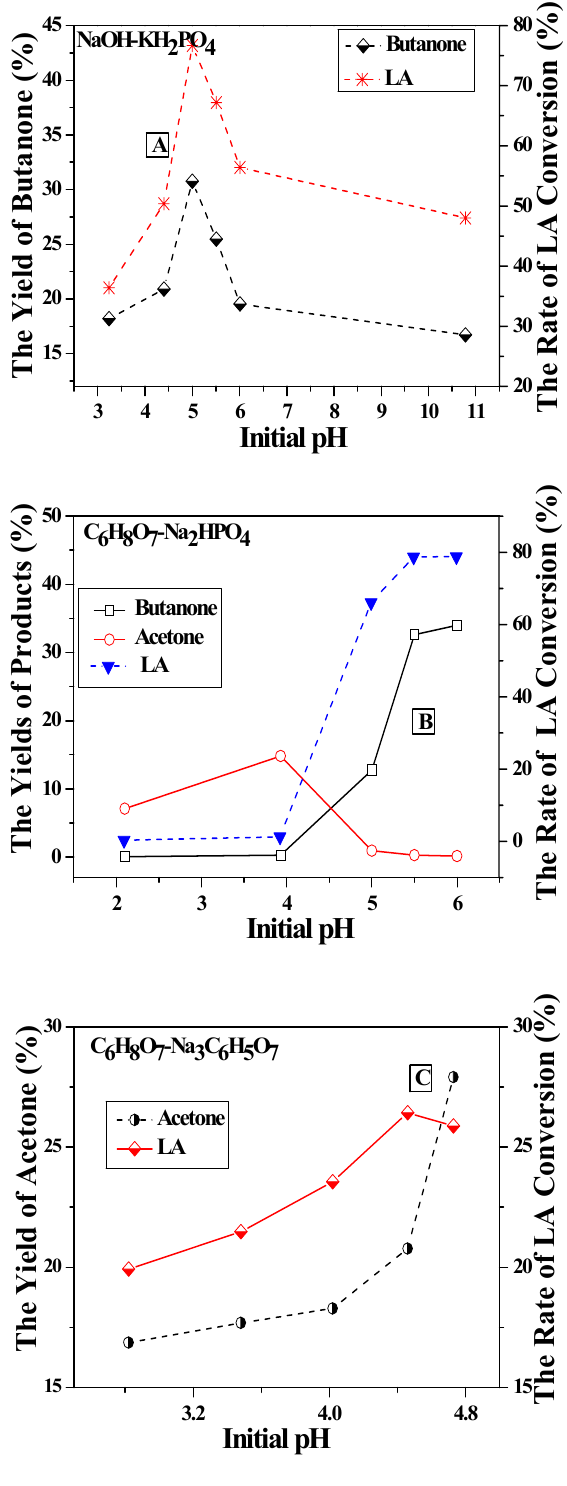
Figure 1. Effect of initial pH on the decarboxylation of levulinic acid in different buffer solutions (A: NaOH-KH 100 °C; time: 0.5